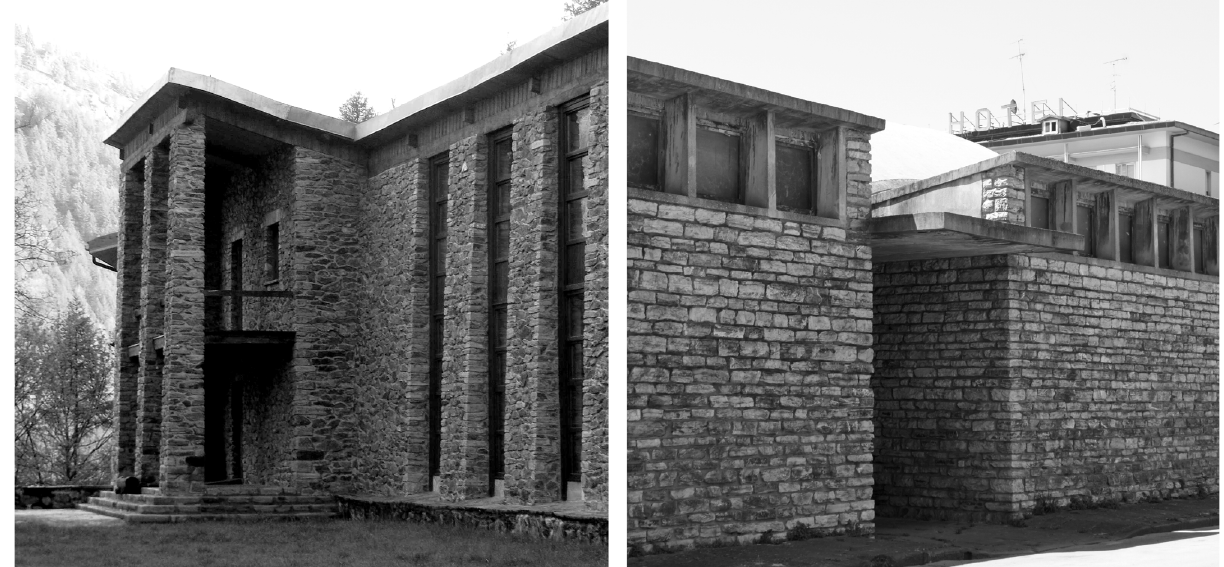
Fig. 2 Left: L. Ricci, Waldesian Village, Agape (1947-51); right: Merca- to dei Fiori, Pescia: storages